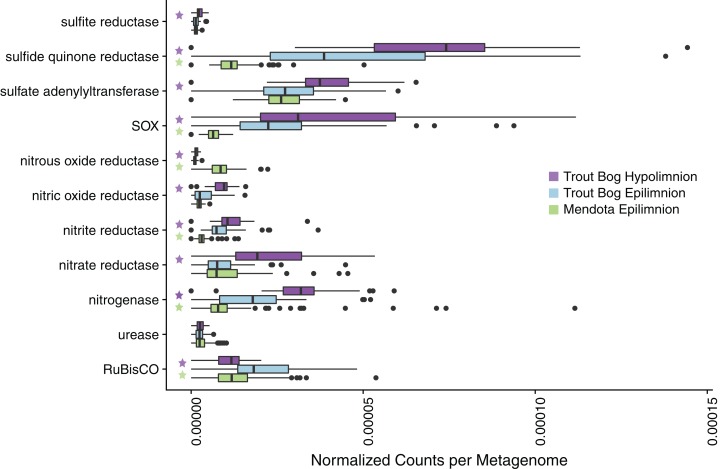
Analysis of marker gene abundances reveals differences between lakes and layers.To assess potential differences in microbial metabolisms in our study sites, we predicted open reading frames in unassembled metagenomes using Prodigal and compared the resulting ORFs to a custom database of metabolic marker genes using BLAST. In these boxplots, significant differences in numbers of gene hits between sites were tested using a pairwise Wilcoxon rank sum test with a Bonferroni correction; significance was considered to be p < 0.05. A total of 94 metagenomes were tested for Mendota, while 47 metagenomes were tested in each layer of Trout Bog. Significant differences between the Trout Bog and Mendota epilimnia and between the Trout Bog epilimnion and hypolimnion are indicated by a green or a purple star, respectively. Significant differences between the Trout Bog hypolimnion and the Mendota epilimnion were not tested, as the large number of variables differing in these sites makes the comparison less informative. This analysis revealed differences in the number of marker genes observed by lake for many metabolic processes involved in carbon, nitrogen, and sulfur cycling. p-values of markers described in Fig. 1 and elsewhere in the text are reported in Table S3.